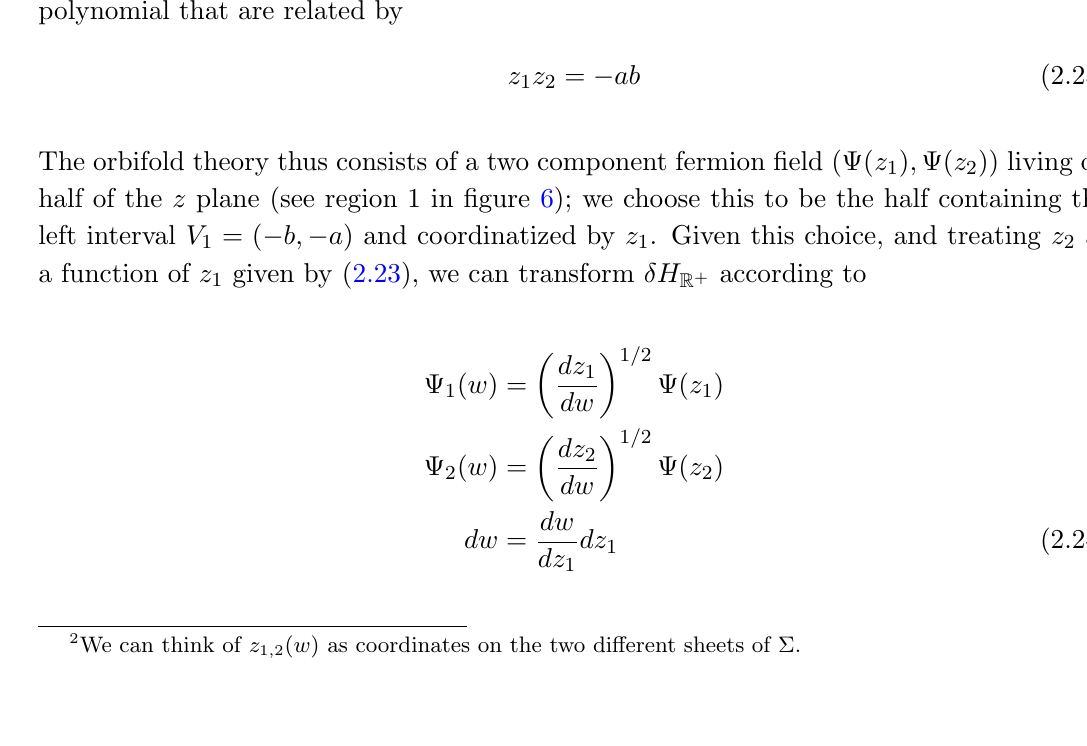
wT V ( w ) dw + (cid:22) w (cid:22) T V ( (cid:22) w ) d (cid:22) w , which is inte- V ( (cid:18) ) V ( (cid:18) ) R R